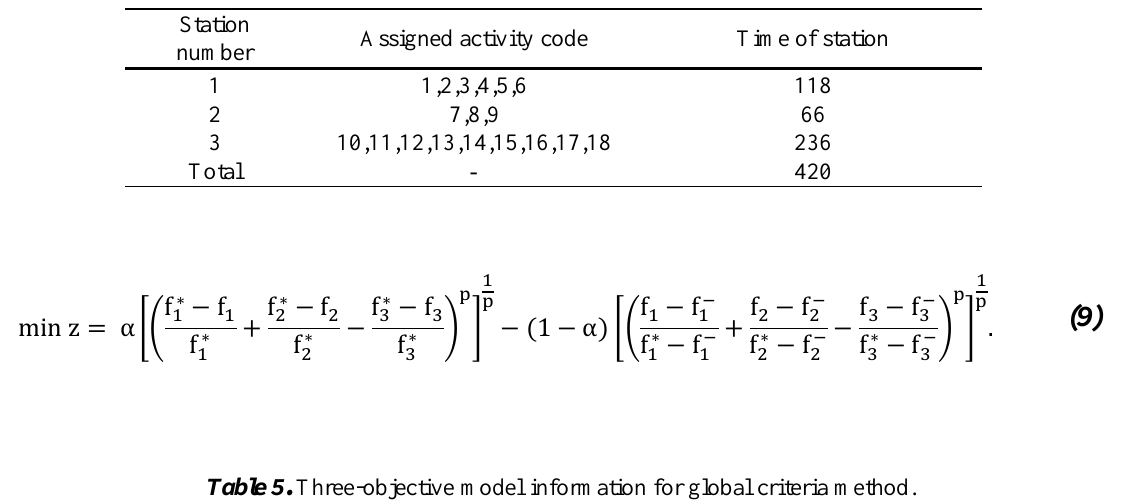
Table 4. Workstations current status.